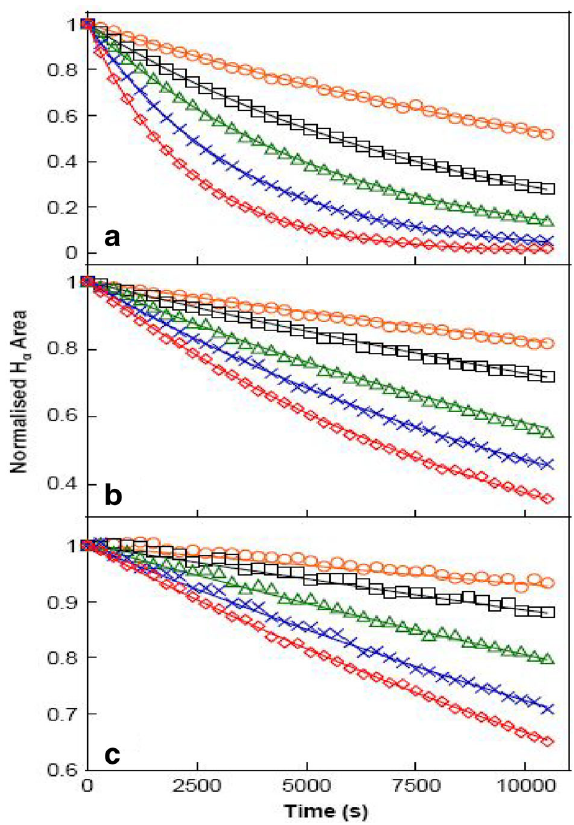
Fig. 9 The decrease in H a signal of curcumin in a methanol, b acetone and c acetonitrile as a function of time 25–45 (cid:3) C. The solid curves represent the line of best-fit result of analysis with rate equations Table 5 Rate constant of tautomerisation of curcumin in methanol, acetone and acetonitrile several temperatures